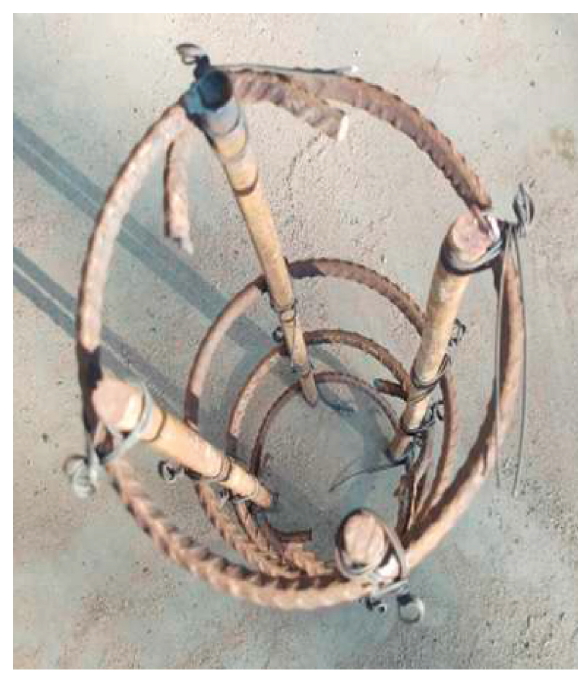
Figure 7: Reinforcements used in column casting.